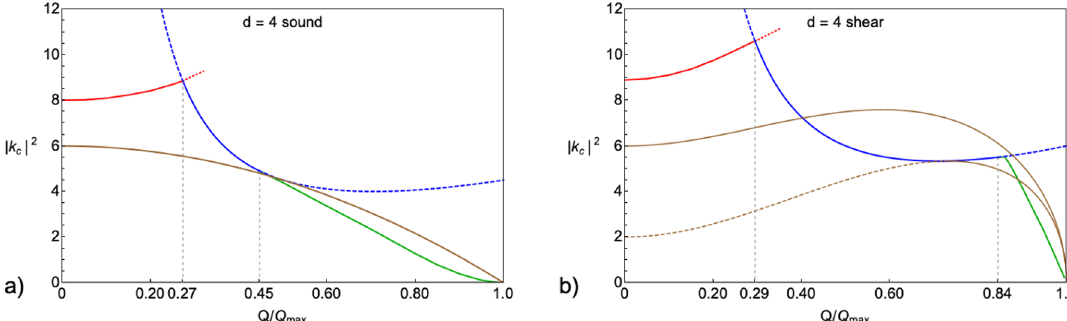
Figure 6 . Panel (a): comparison of the radius of convergence for the sound mode for d = 4 with j z chaos j as a function of ~ Q = Q=Q max . Panel (b): comparison of the radius of convergence for (cid:3) the shear mode for d = 4 with the two solutions in j z vec(1) (cid:3) j , which are depicted in brown. The top brown line corresponds to pole skipping along the hydrodynamic shear mode dispersion. The bottom brown curve correspond to pole skipping points along the transverse gauge mode (dashed segment) and a gapped mode in the shear channel (solid segment). In both panel (a) and (b) we see that as the charge in the system is varied, the relationship between the two quantities changes.